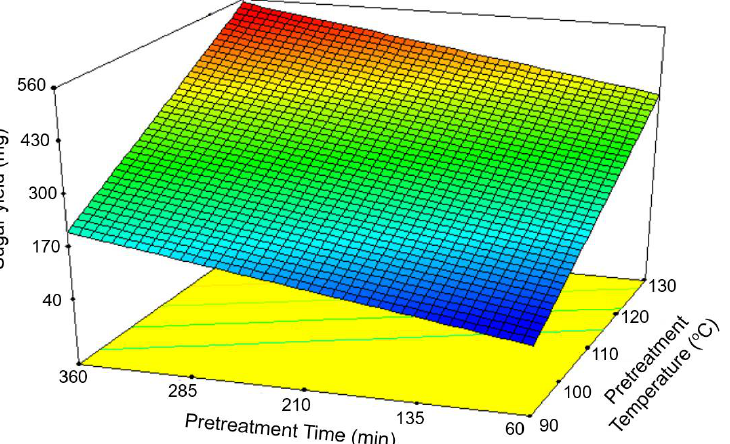
Figure 1. Response surface plot for the visualization of pretreatment effects (pretreatment temperature and pretreatment time) on sugar yield.